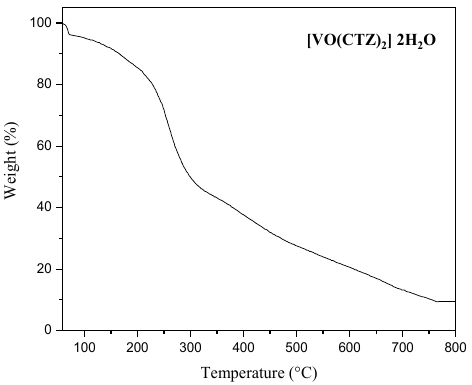
Figure 5. The TGA curve decomposition in the range 25–800 °C of [VO(CTZ) 2 ] 2H 2 O